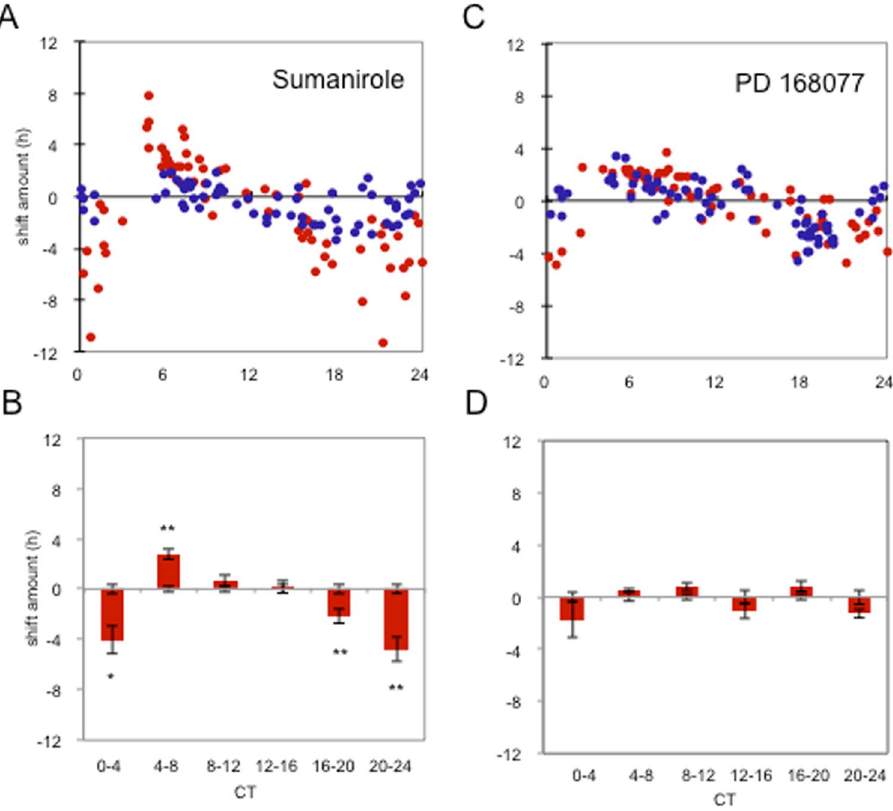
Figure 4. Effects of D 2 R (Sumanirole) and D 4 R (PD168077) agonists on the PER2::LUC bioluminescence rhythm. Sumanirole of 1 µ M significantly phase-delayed PER2::LUC bioluminescence rhythm at CT 0–4, CT 16–20, and CT 20–24 h. Sumanirole significantly phase-advanced the bioluminescence rhythm at CT 4–8 ( A and B ). PD166077 did not phase-shift the PER2::LUC bioluminescence rhythms ( C and D ). Blue circles indicate cultures treated with vehicle and red circles indicate culture treated with active compounds ( A and C ). Data were divided to 6 bins at 4-hour intervals for statistical analysis (Two-way ANOVA following Tukey tests, * p < 0.05) n = 6–21 for each bin ( B and D ). Data were then used to calculate the phase change of drug treated versus their vehicle controls. Bars show the mean amount of phase change from controls and error bars show ± SEM for experimental groups. Error bars from x axis show ± SEM for control